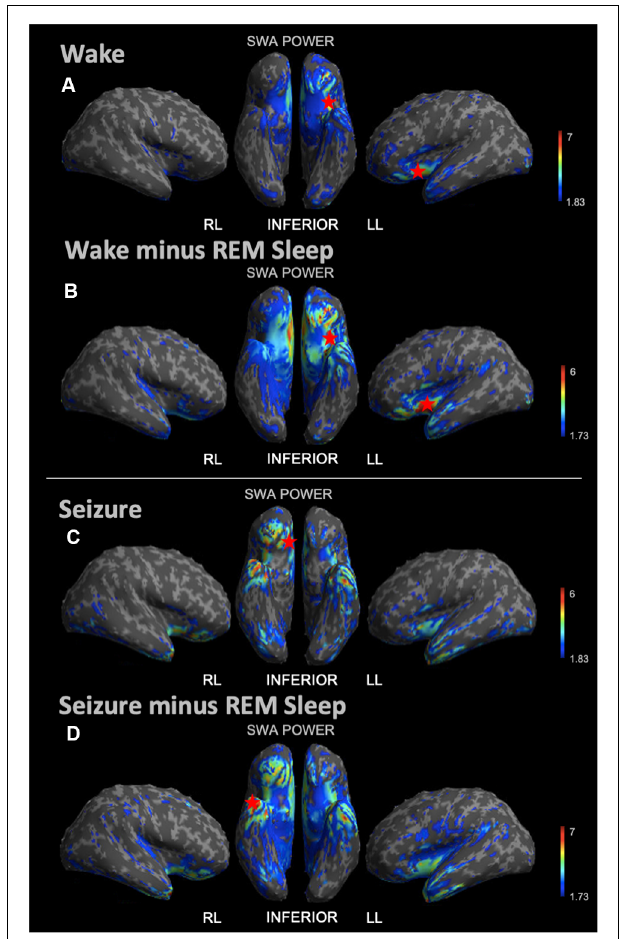
FIGURE 4 | Source space reconstruction of SWA power for the patient vs. controls during wake and seizure states, both taken in isolation and when subtracted by REM sleep. Red stars denote SWA maximums. We observed the SWA maximum during wakefulness in the left inferior frontal lobe. We observed the SWA maximum during seizure within the right limbic area. When these states were first subtracted by intrasubject REM sleep SWA before statistical re-analysis, we again observed the wakefulness SWA maximum in the left inferior frontal lobe, albeit with a higher power; and for the seizure state, we observed the SWA maximum within the right temporal lobe. (A) Patient vs. controls mean SWA power during wakefulness; the red star shows the SWA maximum. (B) SWA power in patient vs. controls for wakefulness subtracted by REM sleep; the red star shows the SWA maximum. (C) Patient seizure SWA power vs. controls wakefulness SWA power. (D) Patient seizure vs. controls wakefulness SWA power subtracted by REM sleep SWA power; the red star shows the SWA maximum. Each T map pictured above is thresholded for a display of uncorrected p < 0.05. The jet color scale indicates t -values. Abbreviations: RL = right lateral; LL = left